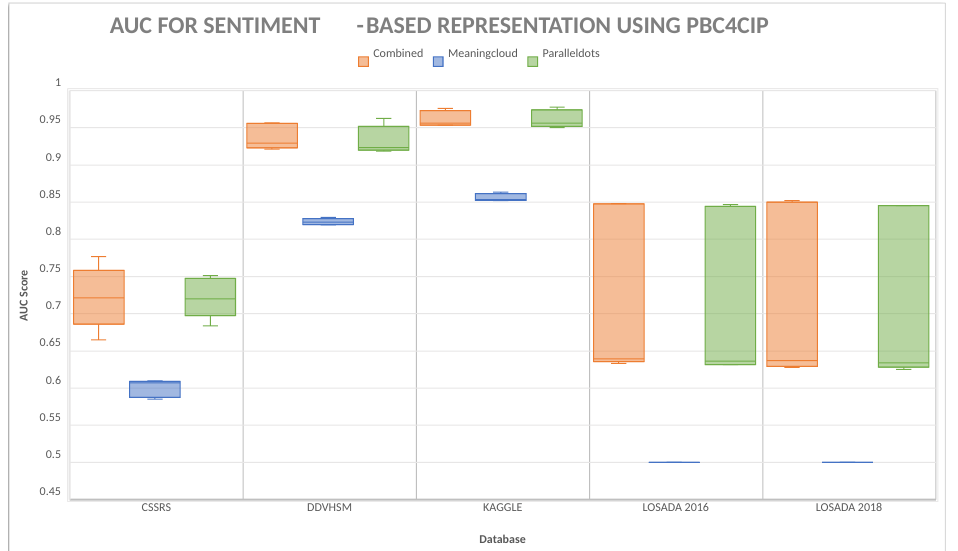
Figure 3. A comparison plot of the AUC for the proposed sentiment-based representations using PBC4cip